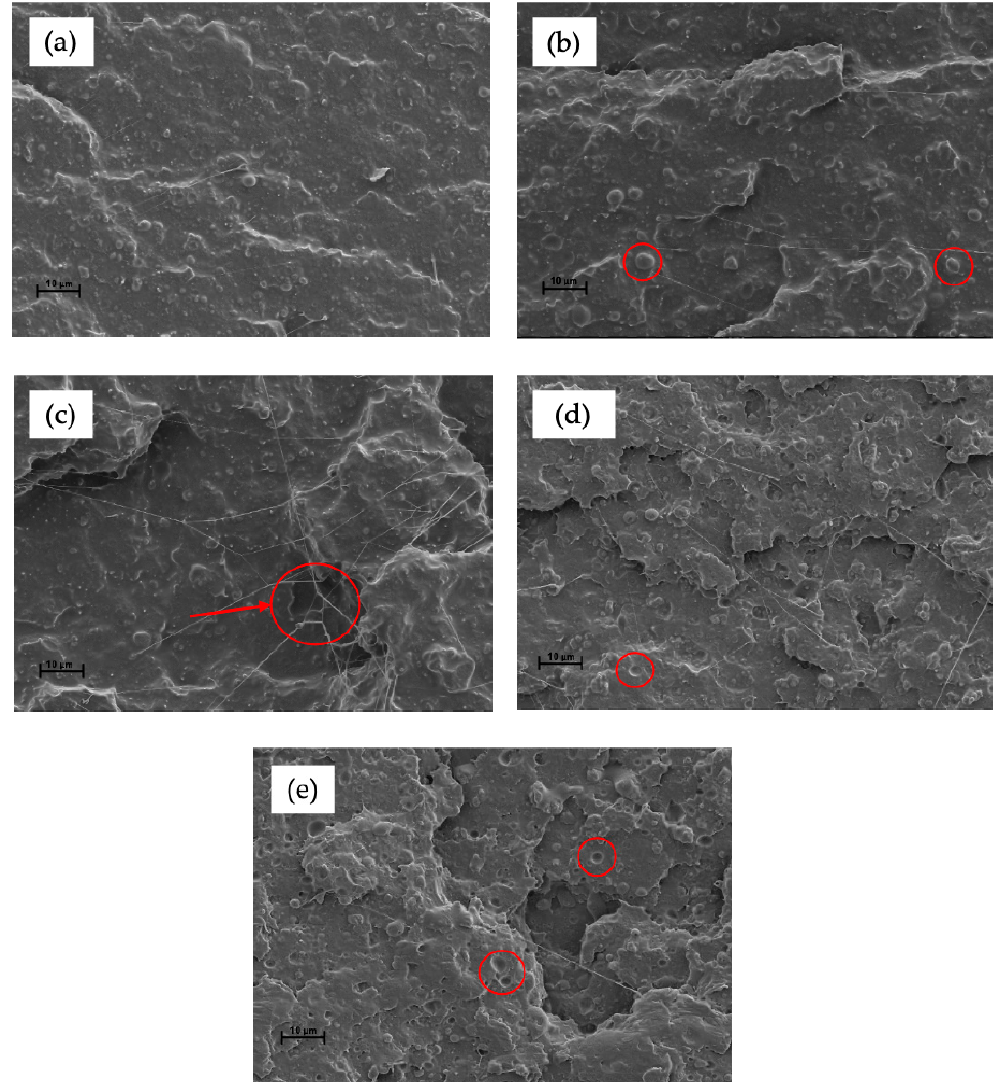
Figure 4. FESEM images (1000×) of the cross-section of the fractured PLA/TPS samples with MHO: ( a ) PLA/TPS; ( b ) PLA/TPS_2.5-MHO; ( c ) PLA/TPS_5.0-MHO; ( d ) PLA/TPS_7.5-MHO and ( e ) PLA/TPS_10-MHO.